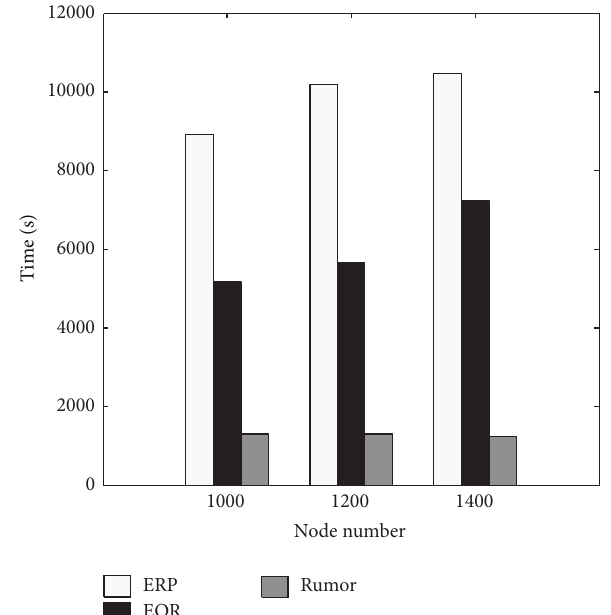
Figure 4: Test 1: time until the first node runs out of